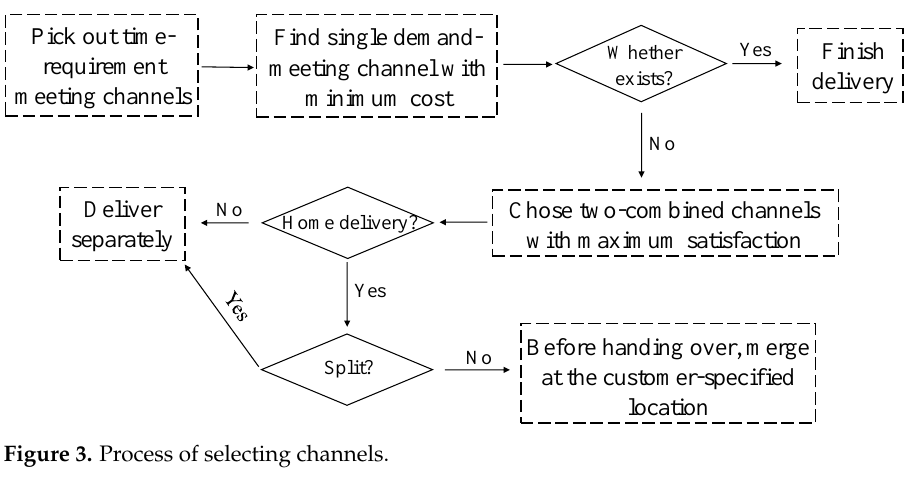
Figure 3. Process of selecting